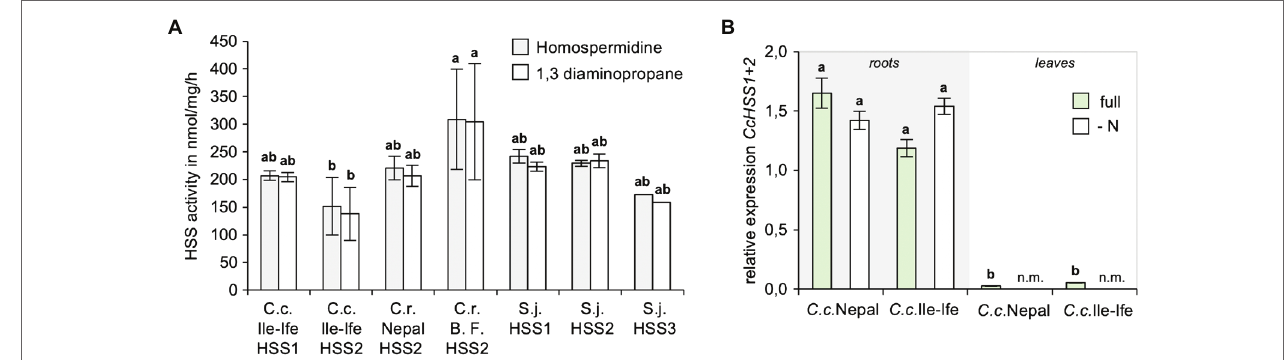
FIGURE 5 | HSS1 and HSS2 of Crassocephalum crepidioides are enzymatically active and mainly expressed in roots. (A) Comparison of in vitro activities of HSS1 and HSS2 of Crassocephalum crepidioides with HSS2 of Crassocephalum rubens and HSS versions of Senecio jacobaea . Recombinant, His-tagged proteins were used in in vitro enzyme assays with spermidine and putrescine as substrates and analyzing formation of spermidine and the by-product 1,3-diaminopropane by HPLC. The columns and bars represent the average and standard error of 1–5 independent biological replicates. Letters above the bars indicate p < 0.05, ANOVA followed by Tukey’s HSD test (homospermidine: ANOVA F 6,13 = 4.406, p = 0.012; by-product: ANOVA F 6,13 = 4.648, p = 0.010). (B) qPCR analyses of CcHSS1 +2 expression in leaves of Crassocephalum crepidioides plants grown hydroponically either in full or in nitrate drop-out medium. The average and standard deviation of 3 independent biological replicates. Letters above the bars indicate p < 0.05, ANOVA followed by Tukey’s HSD test (ANOVA F 5,11 = 15.781, p = 0.0001). n.m., not